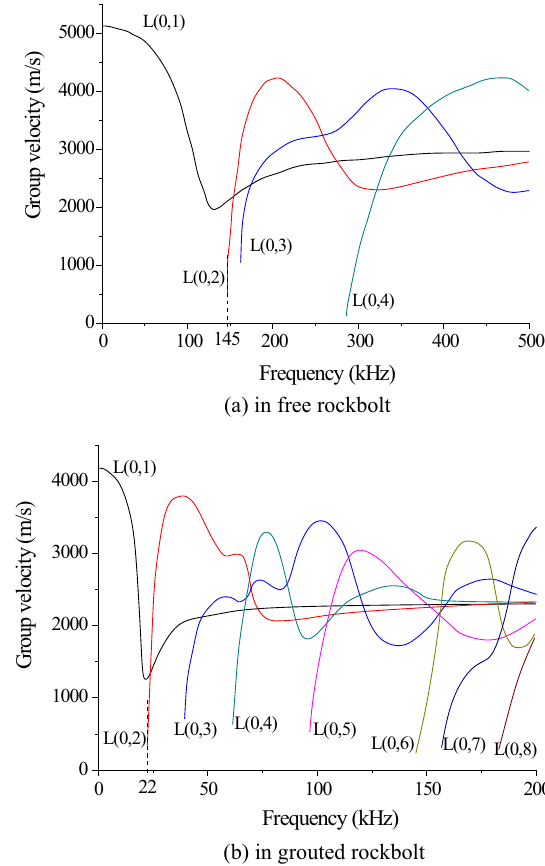
Fig. 1 Frequency dispersion curves of group velocity of guided wave in